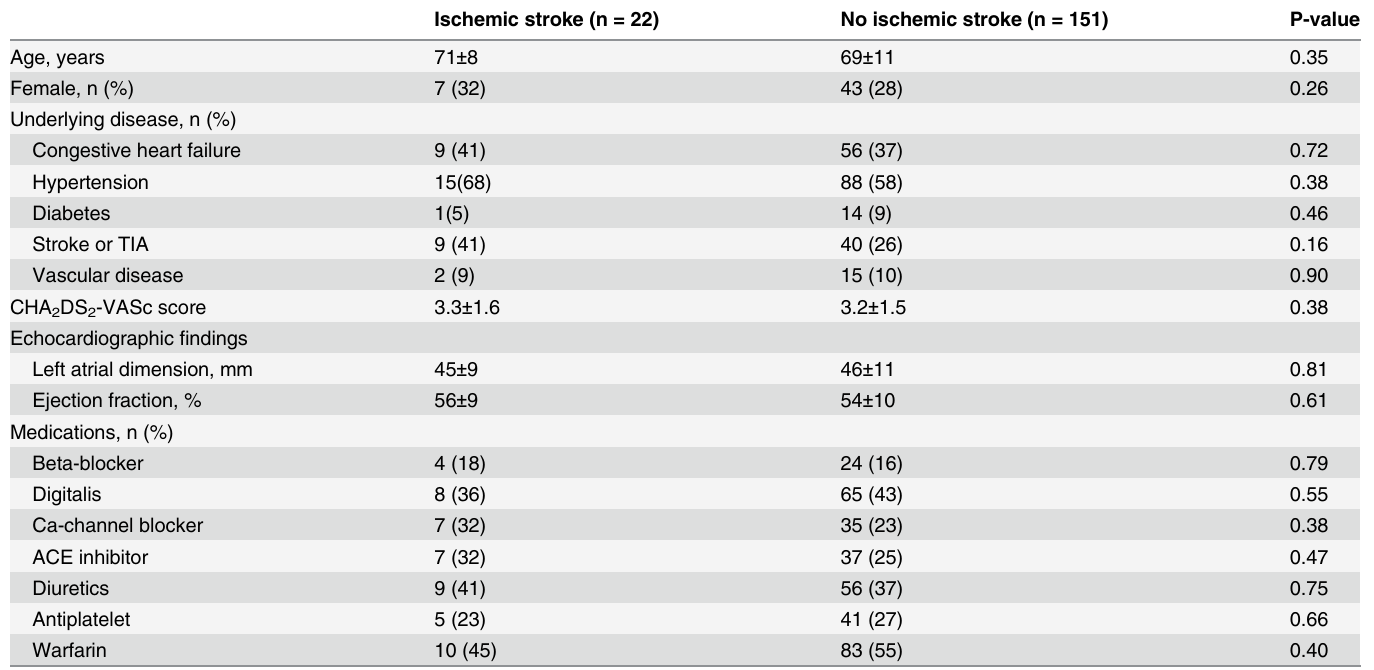
Table 1. Baseline clinical characteristics of the patients. Ischemic stroke (n = 22) No ischemic stroke (n = 151)